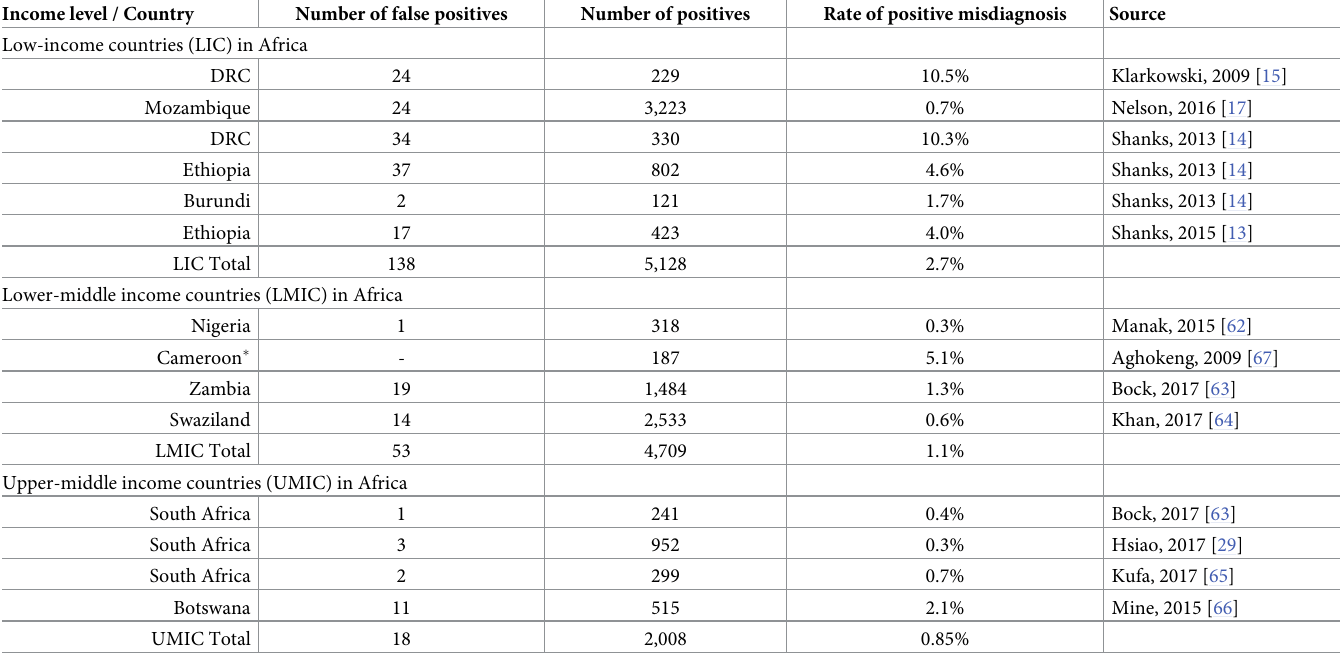
Table 2. Review of false positive misdiagnosis in